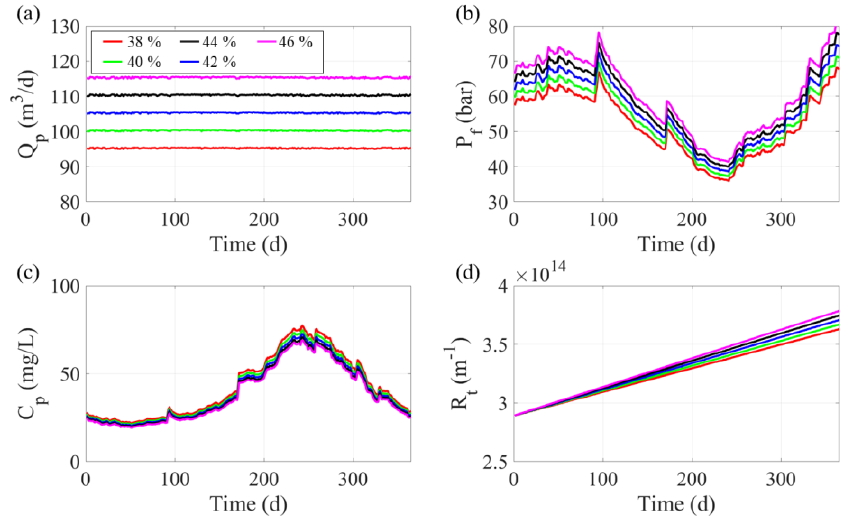
Figure 3. Simulation results for the seawater reverse osmosis algorithm with respect to five different recovery ratios: ( a ) permeate flow rate (m 3 /d), ( b ) operating pressure (bar), ( c ) permeate total dissolved solids concentration (mg/L), and ( d ) total membrane resistance (m −1 ).